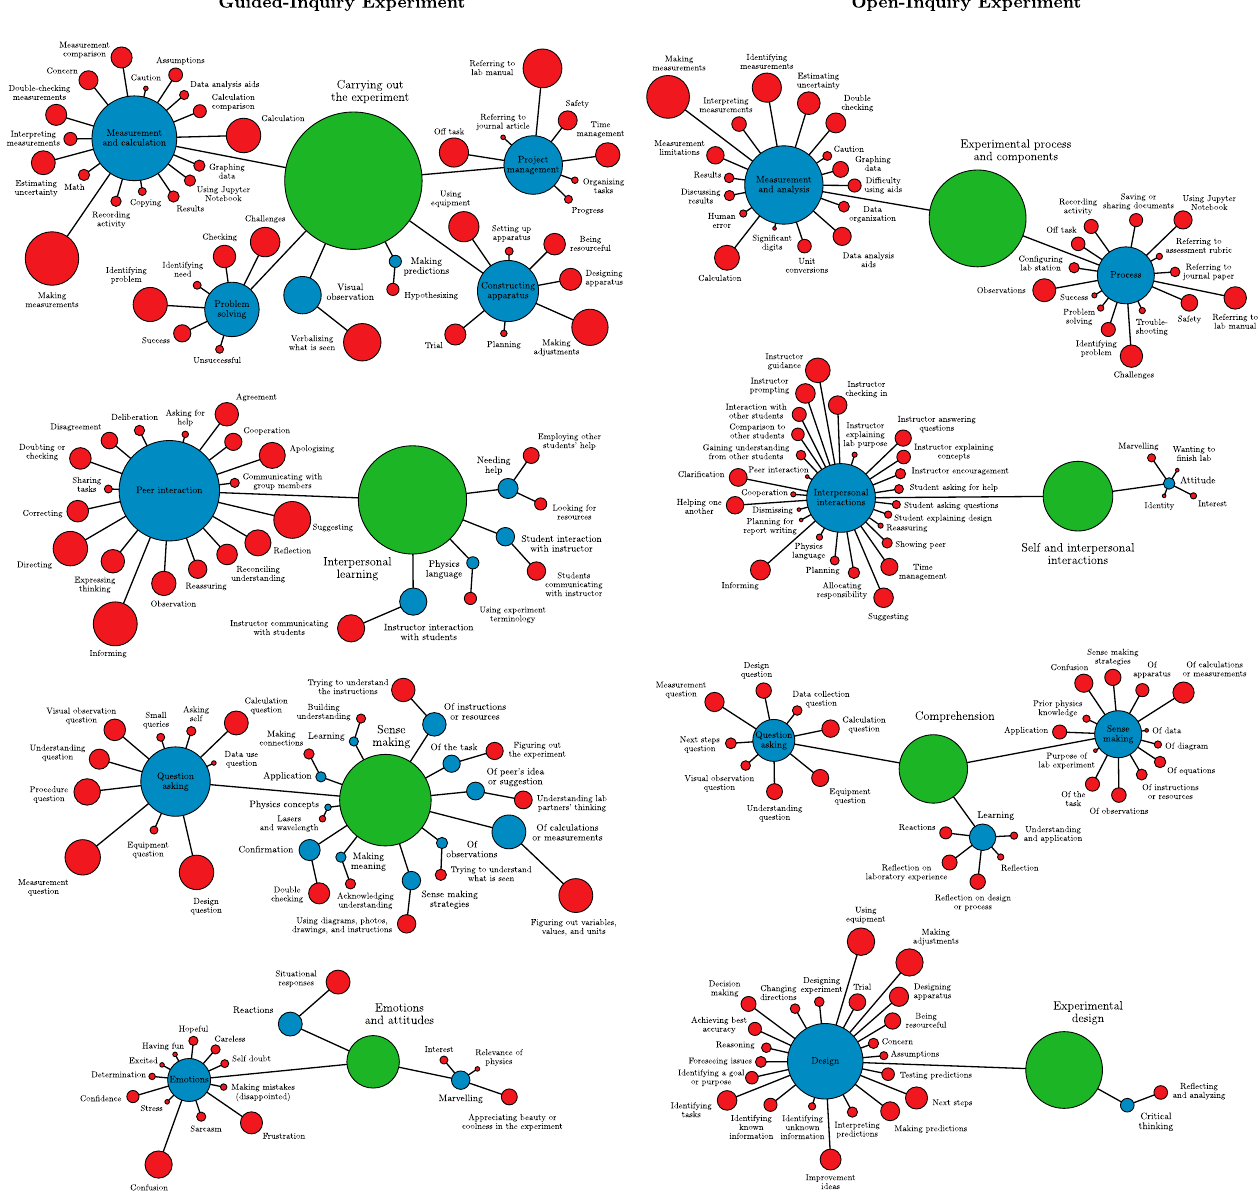
FIG. 2. The complete picture of our qualitative and quantitative analysis results. All categories and codes in each theme are shown for the guided-inquiry experiment (left) and for the open-inquiry experiment (right). The area of each node scales with the frequency of the theme (green), category (blue), and code